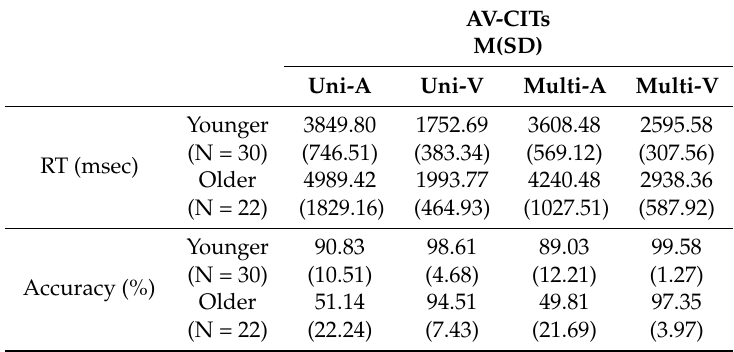
Figure 5. Changes in ( a ) response time and ( b ) accuracy across audio-visual contour identification tasks (AV-CITs). Uni-A: Unimodal Auditory Contour Identification; Uni-V: Unimodal Visual Contour Identification Task; Multi-A: Multimodal Auditory Contour Identification Task with Visual Distraction; Multi-V: Multimodal Visual Contour Identification Task with Auditory Distraction. Table 2. Descriptive statistics of response time and accuracy across audio-visual contour identification